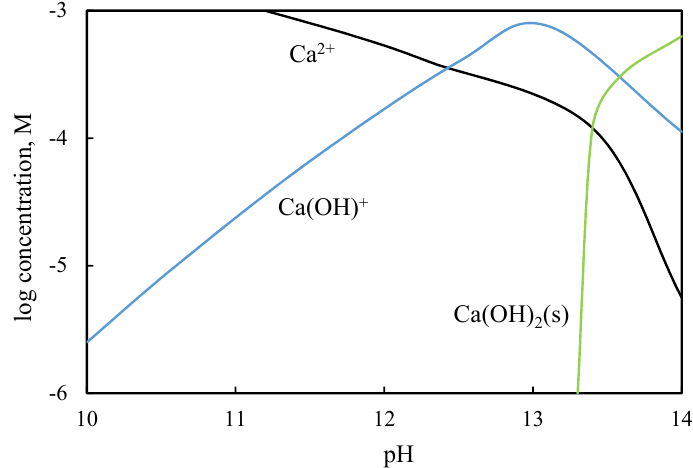
Figure 2. Species distribution diagrams of Ca 2 + as a function of pH (total concentration = 1 × 10 − 3 mol / L) (after [26]).